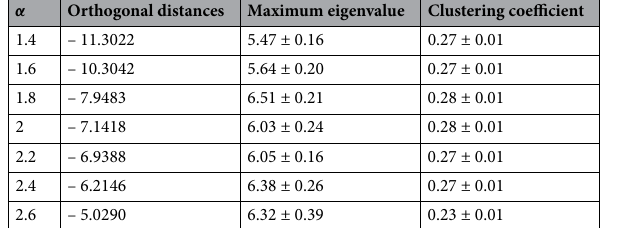
Table 1. General properties of the constructed HVGs (with 14,000 nodes) for the nano-flare emission model. The model parameters are α ∈ [1.4 3.2], τ d = 10, and p f < 0.2 .